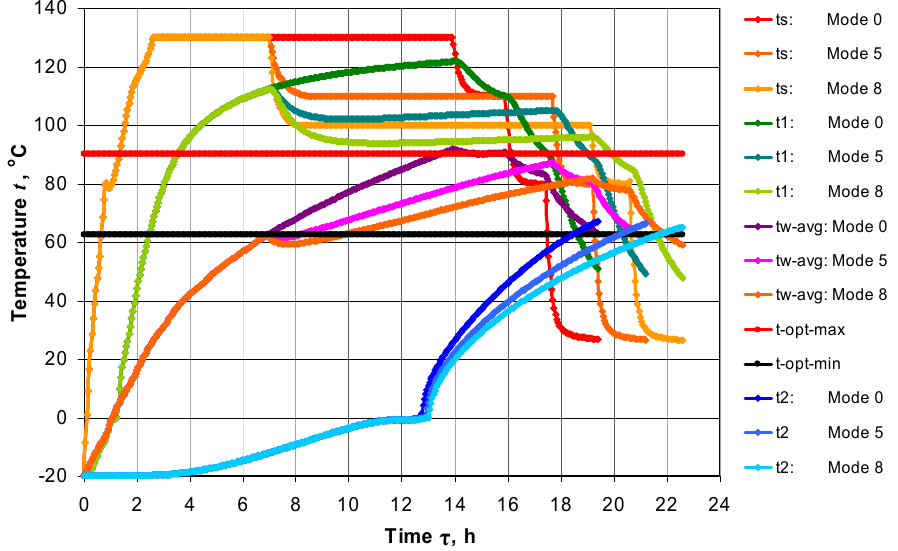
Figure 3. Changes in t s , t w-avg , t 1 , and t 2 of the prisms during steaming Mode 0, Mode 5, and Mode 8, depending on τ .